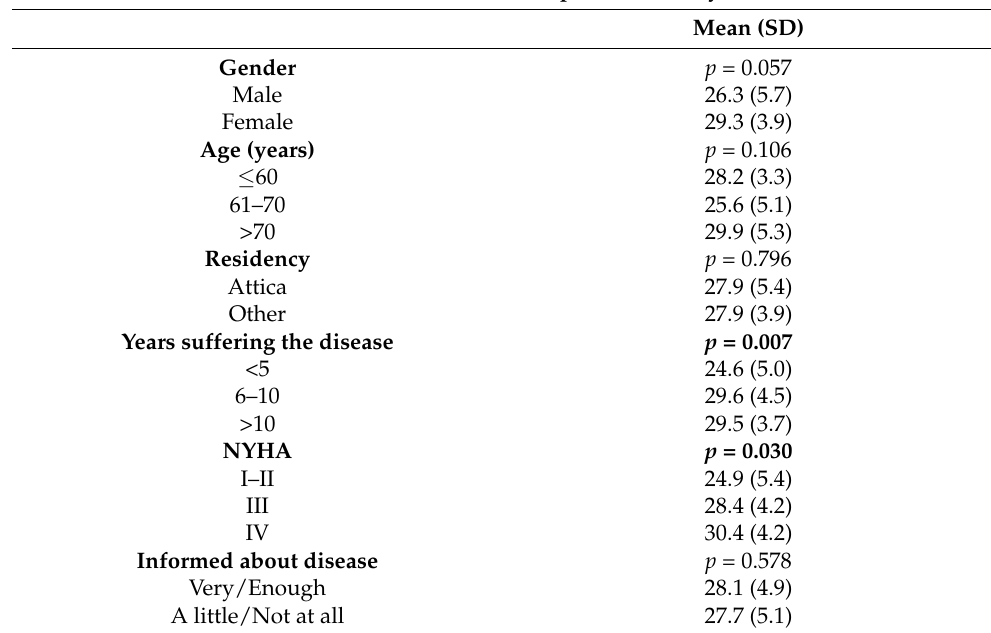
Table 6. Discriminant